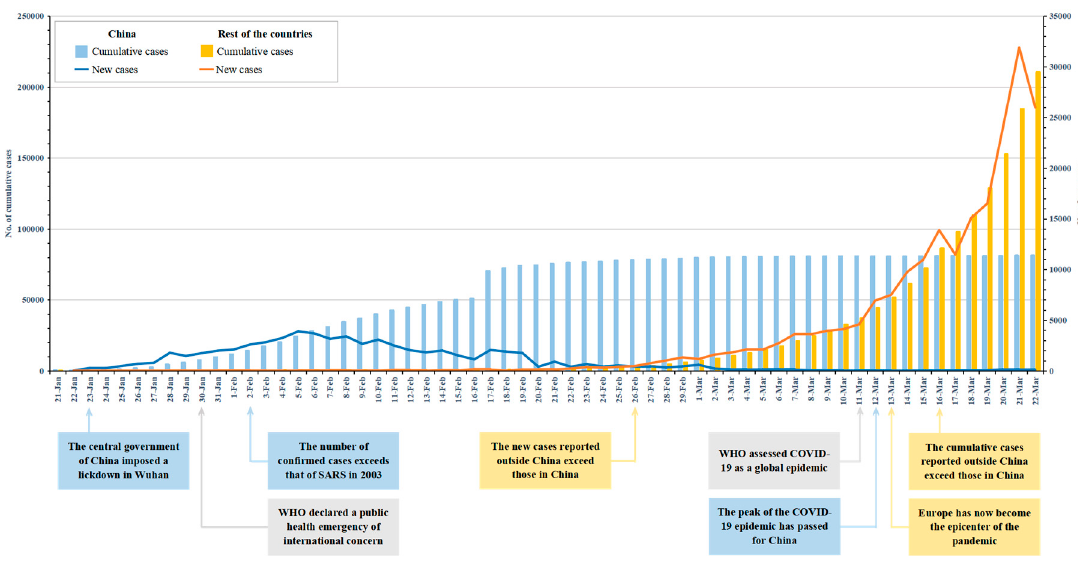
Figure 1. New and cumulative confirmed cases of COVID-19 for China and the rest of the countries by date of report (Data sources: World Health Organization Situation Reports).